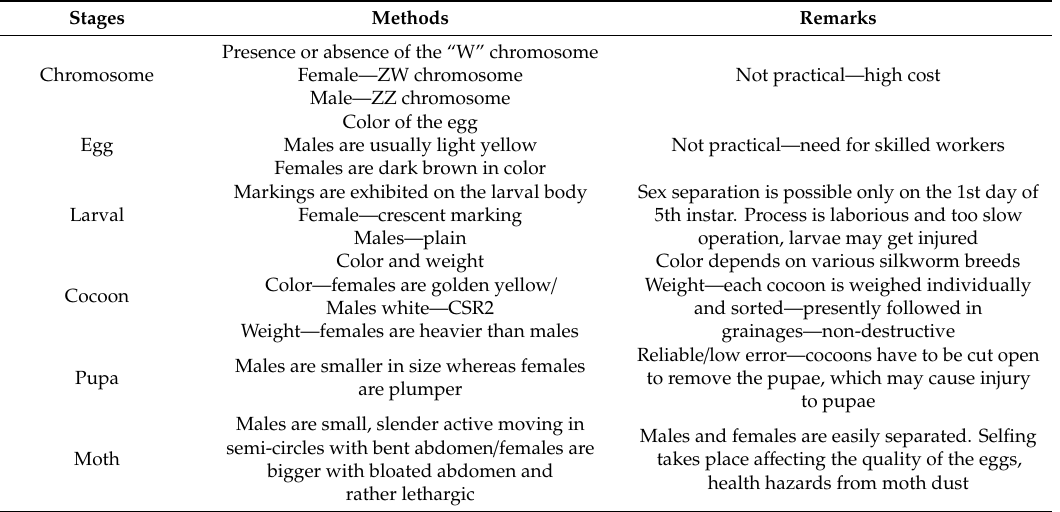
Figure 3. Methods of silkworm gender separation process.